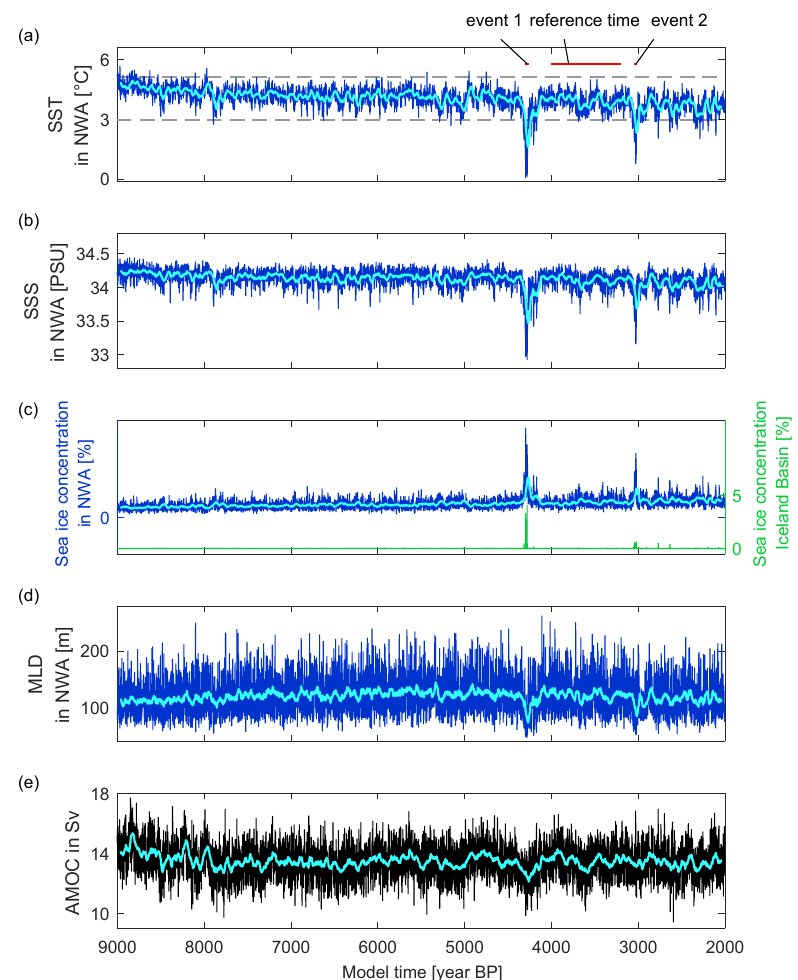
Figure 2. Time series of the annual mean (a) sea surface temperature (SST; in ◦ C) in the NWA, (b) sea surface salinity (SSS; in PSU) in the NWA, (c) sea ice concentration in % in the Iceland Basin (green) and in the northwest Atlantic (NWA, blue), (d) mixed-layer depth (MLD; in m) in the NWA, and (e) AMOC calculated as the maximum of the streamfunction in the Atlantic north of 30 ◦ N and below 500m water depth. The respective 40-year-running means are indicated by the light blue lines. The dashed gray line indicates the 2-standard-deviation range for the SST. The red lines indicate the time spans for the reference time, event 1, and event 2.